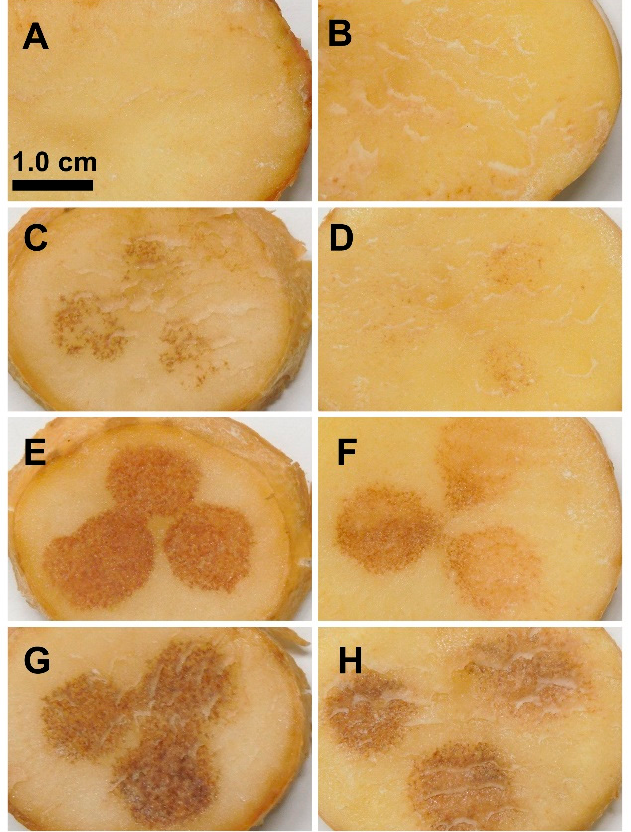
Figure 1. TA induces browning on RB (common scab moderately resistant) and YG (common scab sensitive) tuber slices. Representative pictures of tuber slices of RB ( A , C , E , G ) and YG ( B , D , F , H ) 6 days after treatment with methanol (MeOH) as control ( A , B ) and TA: 1 µM ( C , D ); 5 µM ( E , F ); 10 µM ( G , H ).